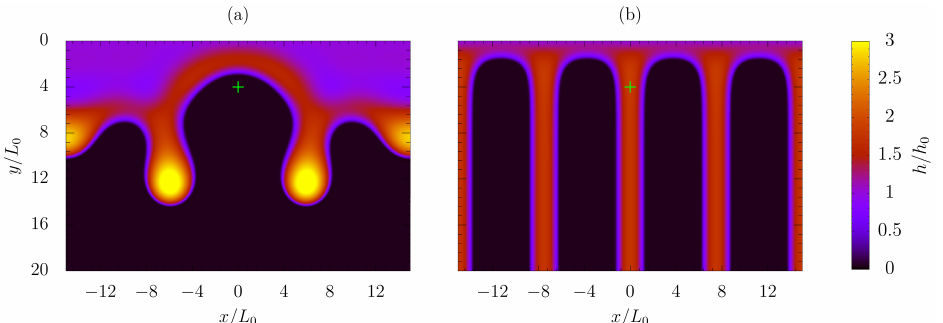
Figure 6. Film thickness solution at T = 11 ( a ); 3 rivulet configuration, steady state film distribution ( b ). Bo = 0.11, L X = 22, α = 60 ◦ , θ s = 60 ◦ (75 ◦ inside contamination spot, denoted by a green cross).